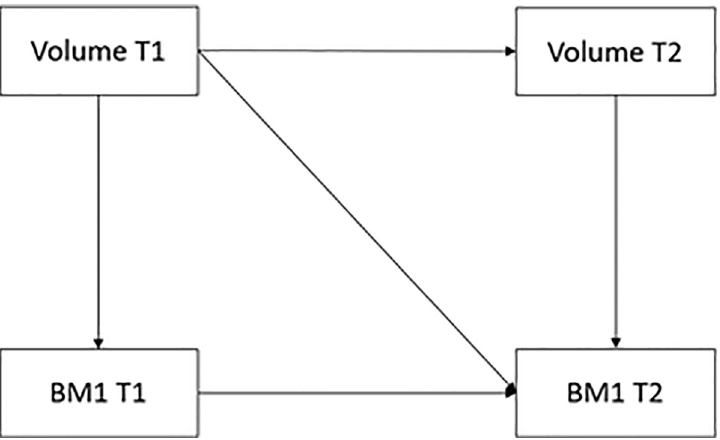
Fig 1. Graphical representation of the structural equation model used to assess the longitudinal relationship between brain region volume and BMI z-score.